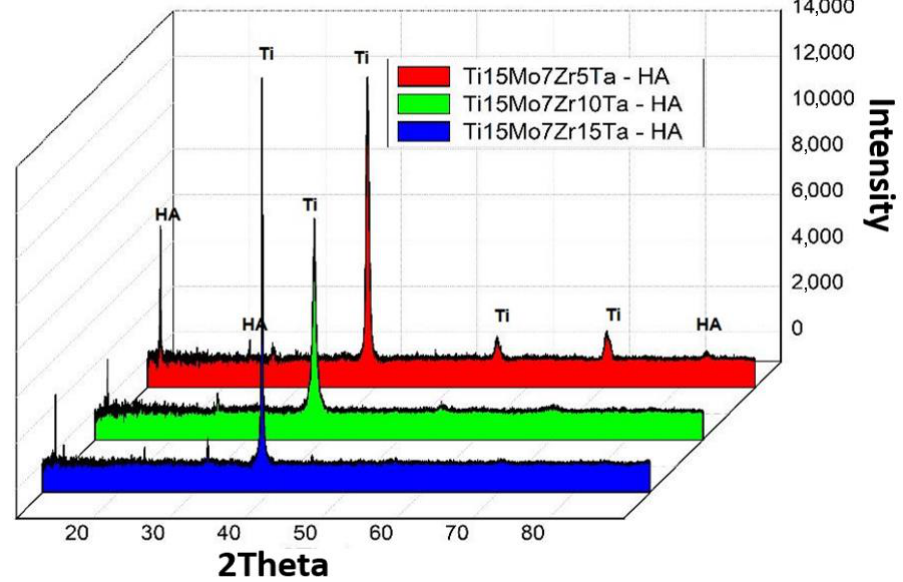
Figure 5. X-ray diffraction (XRD) graph of the coated alloys.